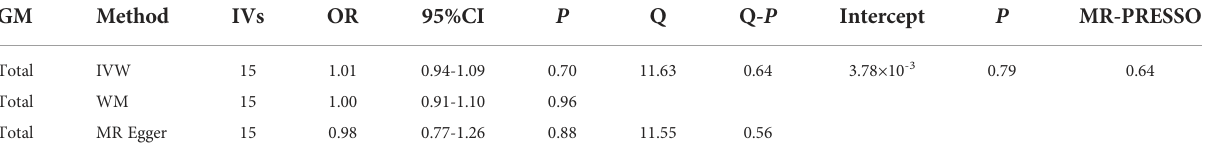
TABLE 4 MR results between GM and DR ( P <5×10 -8 ).